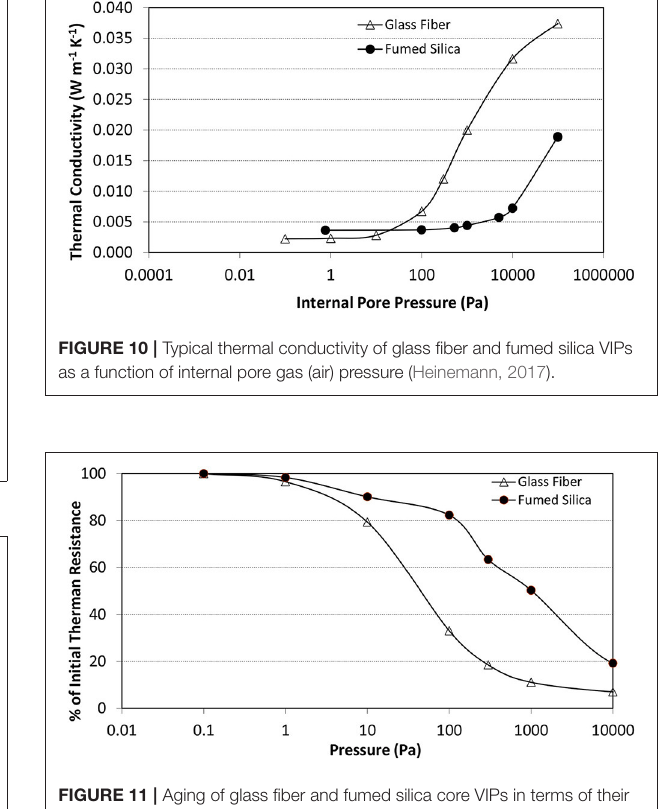
FIGURE 11 | Aging of glass fiber and fumed silica core VIPs in terms of their initial thermal resistance as a function of gas (air) pressure (derived from Figure 10